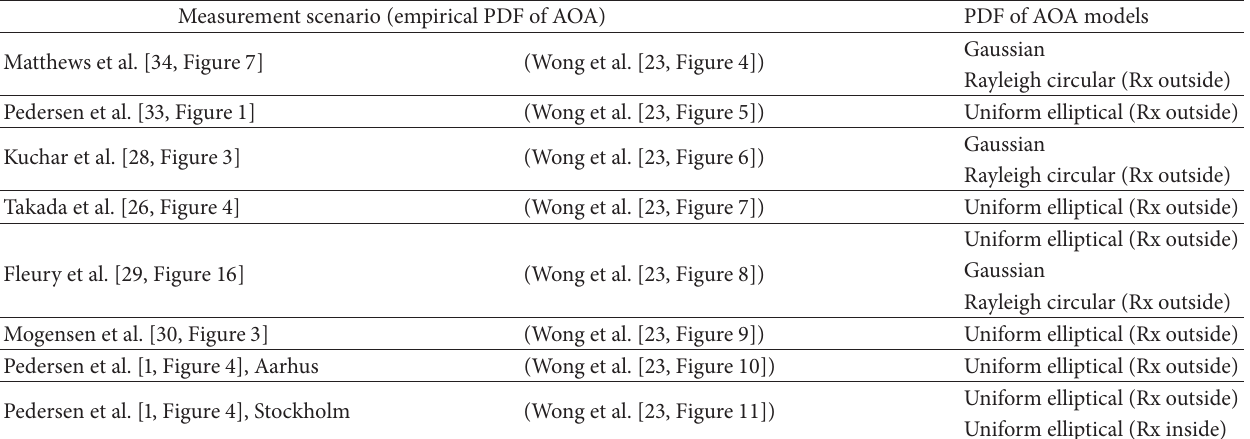
Table 2: Selected test scenarios and the best matched